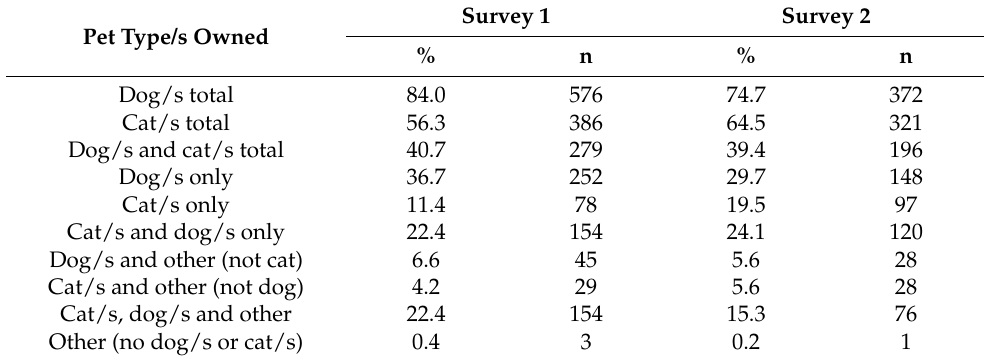
Table 1. The percentage of pet type/s owned in Survey 1 (n = 686) and survey 2 (n = 498).